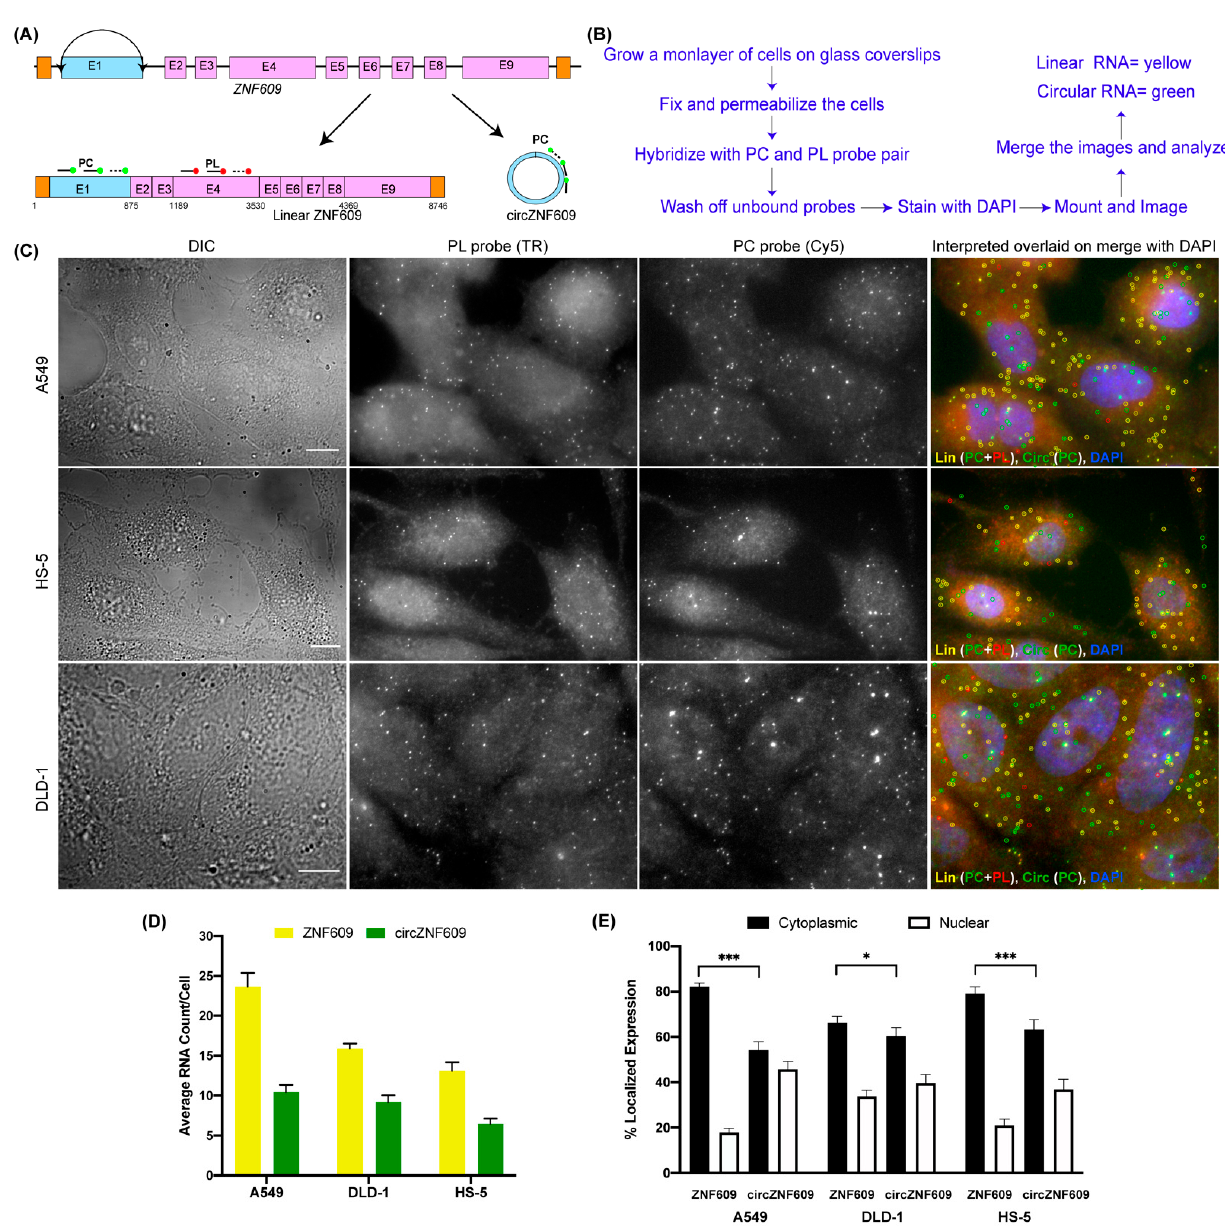
Figure 1. Visualizing circZNF609 using CircFISH. ( A ) Schematic of circFISH for the simultaneous imaging of linear and circular ZNF609. The binding of the PL and PC probes on the linear and circular isoforms, respectively, of ZNF609 is shown by straight lines ending in filled circles. ( B ) Standard protocol for the circFISH method. ( C ) Representative image panel for circFISH for ZNF609 in A549, HS-5 and DLD-1 cells with the PL and PC probes. From the left: DIC; raw merged z stacks of cells for PL probes labeled with TR; raw merged z stacks of cells for PC probes labeled with Cy5; and a merged image of the two channels with TR spots pseudo-colored red and Cy5 pseudo-colored green, overlaid on DAPI with MATLAB-interpreted spots. Full-length linear, circular and fragmented linear RNA is represented as yellow, green, and red spots, respectively. ( D ) Quantification of ZNF609 and circZNF609 signals after MATLAB analysis. The columns represent the average ZNF609 and circZNF609 RNA molecules per cell, as analyzed in MATLAB across the different cell lines. ( E ) Average relative nuclear and cytoplasmic localization of ZNF609 and circZNF609 across the different cell lines. The error bars indicate the 95% confidence interval for at least 100 cells. * Indicates a significant difference with a p -value < 0.05. *** Indicates a significant difference with a p -value < 0.001. The scale bar is 5 µ